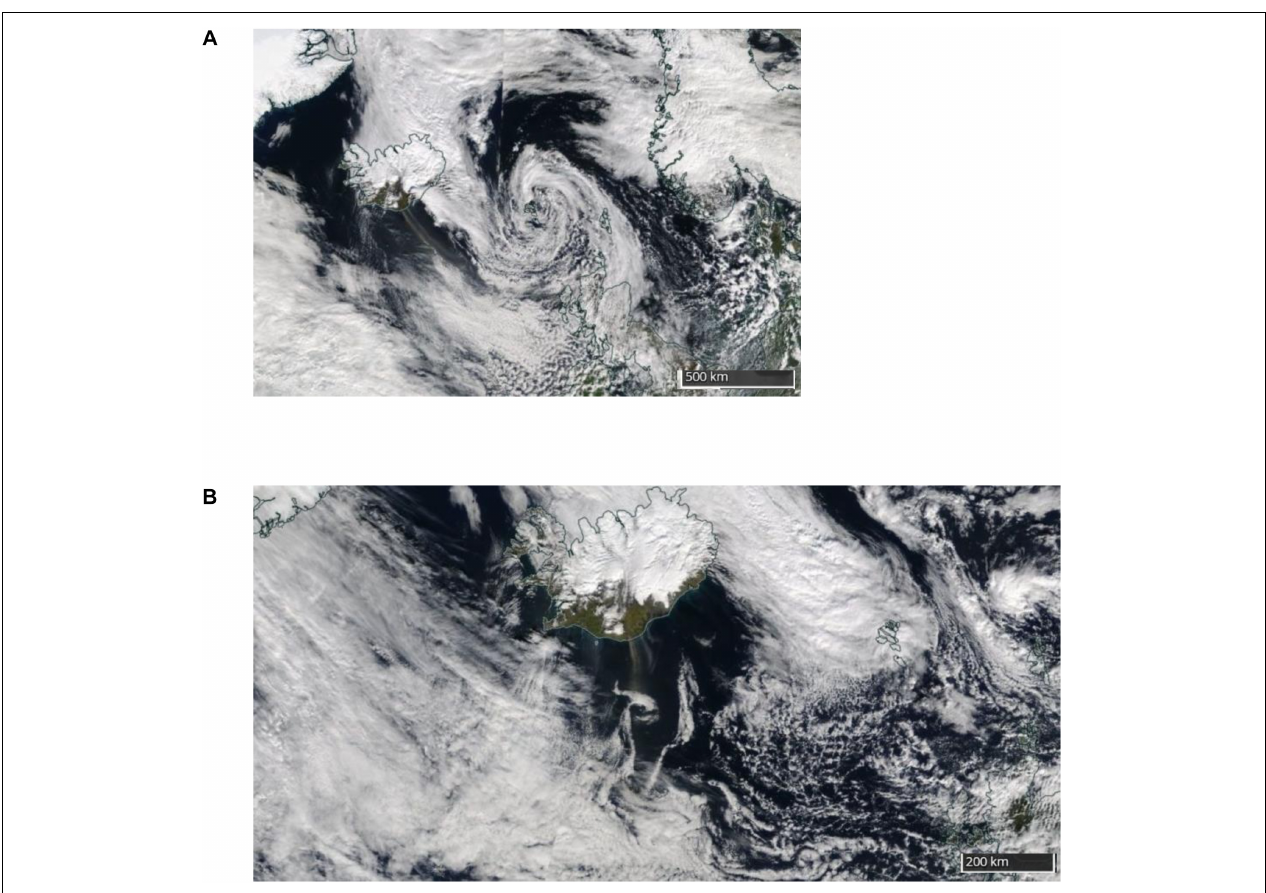
FIGURE 4 | Satellite images of dust storms in South Iceland on September 16 (A) and 17 (B) 2013 captured in true color by the Moderate Resolution Imaging Spectroradiometer (MODIS) flying on NASA’s Terra satellite (Source: NASA/MODIS).